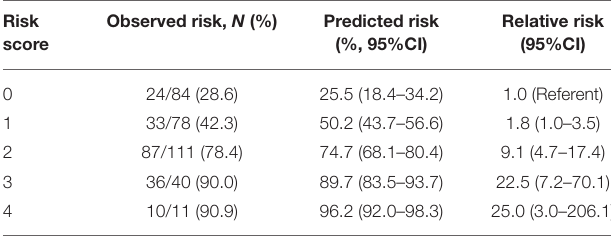
TABLE 4 | Risk of poor outcome by WAP score in the derivation